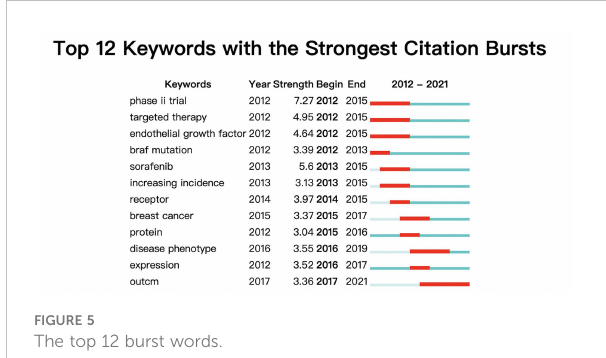
FIGURE 5 The top 12 burst words.